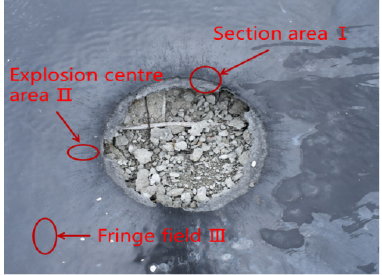
Figure 14. Different explosion regions of coating. The micro-morphology of T26 polyurea coating was enlarged by 4000 times in dif- ferent regions after the explosion. The surface of the section area was torn in different